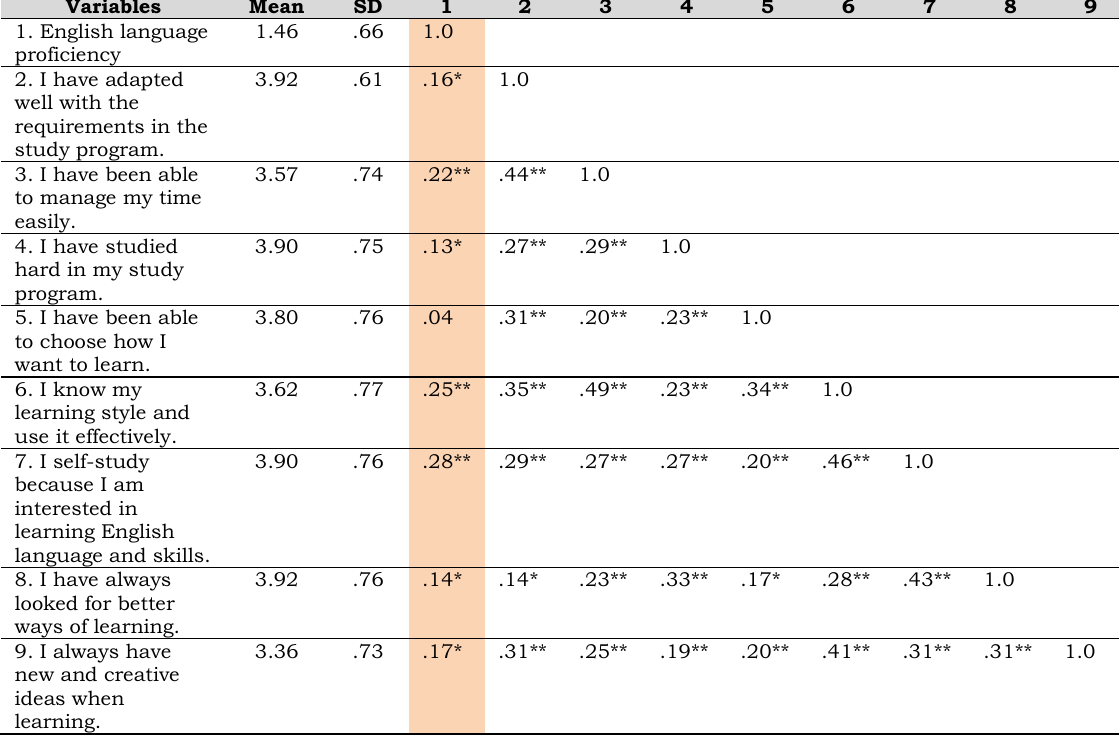
Table 1: Correlation Matrix (observed variables) of students’ EP and various autonomy